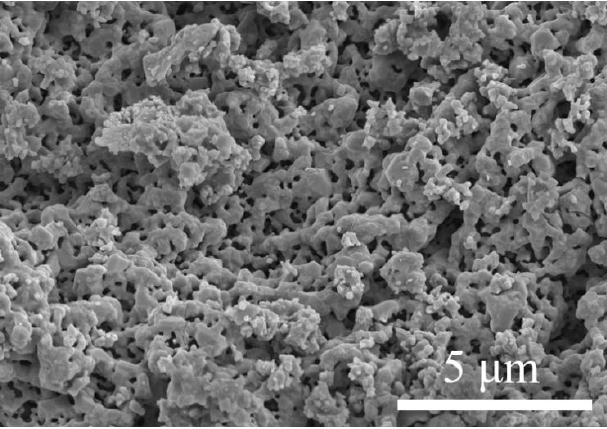
Figure 10. SEM images of 0.3LCMO after circulation.